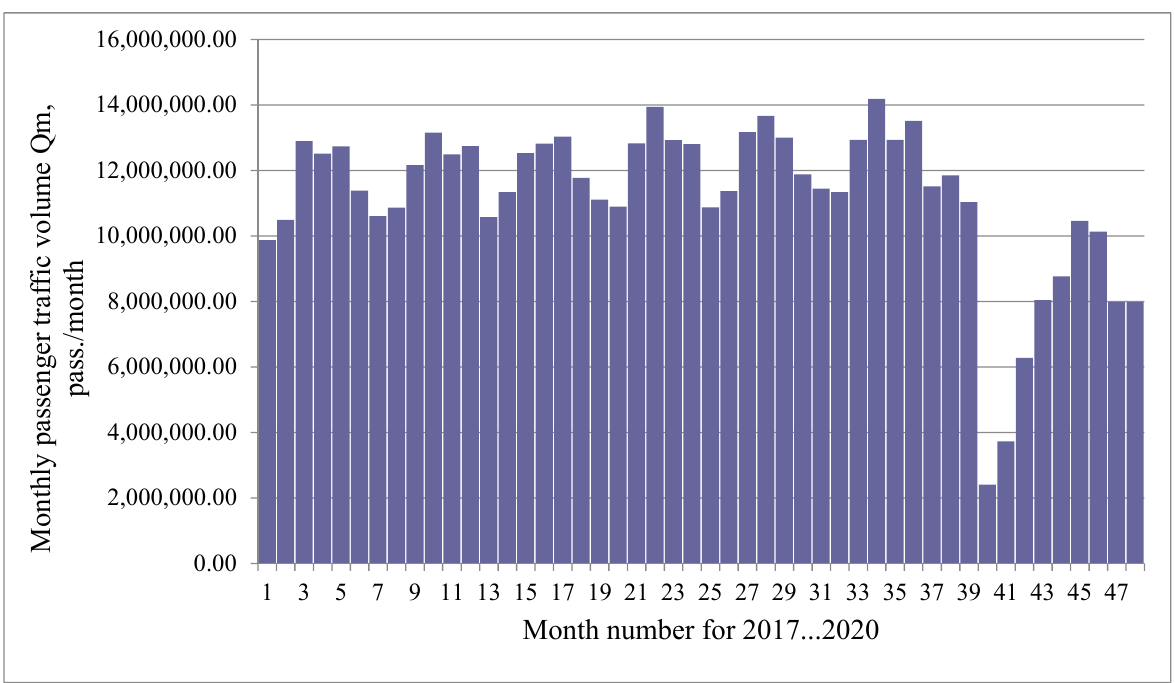
Figure 3. Dynamics of change in regards to the annual value of transportation volume, Q month of the Tyumen CPPT during